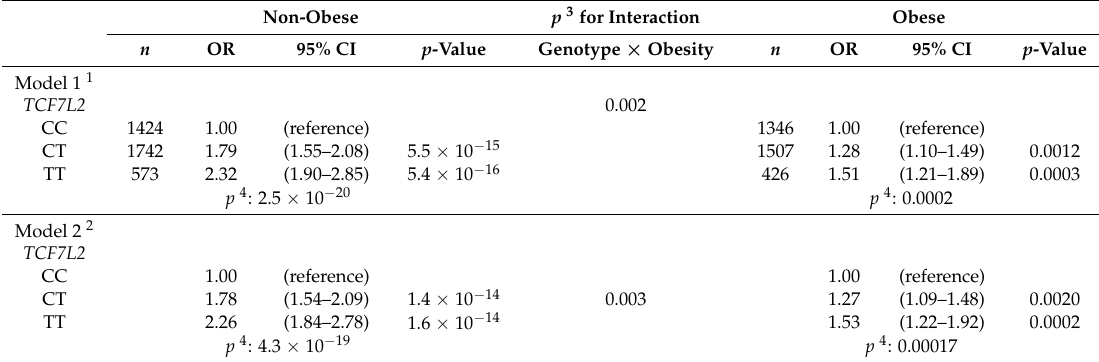
Table 2. Association between the TCF7L2-rs7903146 polymorphism and prevalence of T2D depending on the obesity status at baseline. Stratified logistic regression analysis.